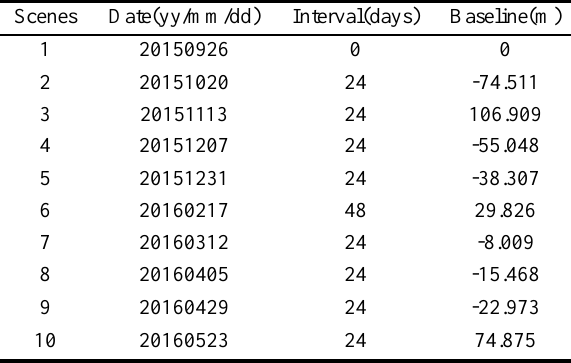
Table 2. Sentinel-1A data and